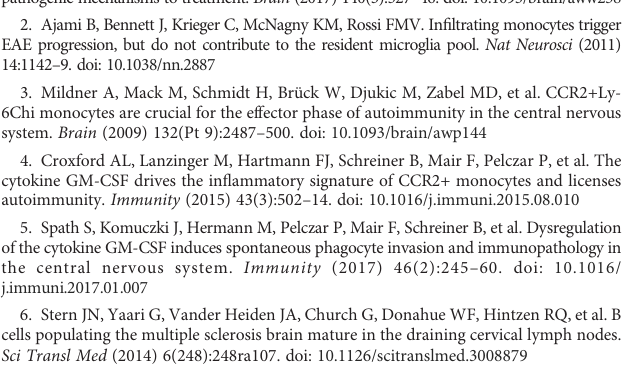
SUPPLEMENTARY FIGURE 10 DifferencesinmajorimmunecellsubsetsamongMSdiseasesubgroupsandhealthy controls. (A – E) Box plots showingthe frequency (expressed as % of CD45+ cells) of each FlowSOM generated metacluster in peripheral blood mononuclear cells of MS patients (n=27; PPMS=8, RRMS=9, TMS=10) and healthy donors. (n=10). The number below each plot represents the generated metacluster. PPMS, Primary Progressive Multiple Sclerosis; RRMS, Relapsing Remitting Multiple Sclerosis; TMS, Tumefactive Multiple Sclerosis; HD, Healthy donors. SUPPLEMENTARY FIGURE 11 Validation of myeloid cell expansion in TMS patients with fl ow cytometry. (A) Gating strategy for the myeloid immune cell phenotype (same cohort that one used in CyTOF). Representative paradigm from one patient is shown in A and generated with FlowJo program. Myeloid cells de fi ned as CD3/CD19/CD56 negative cells (total myeloid) were separated in two groups based on their forward side scattered properties: in those with higher FSC features (FSC high Myeloid) and those with lower FSC features. FSC high Myeloid cell population co-expressed the higher levels of CD11c and CD14, compared to FSC low cells, possibly indicative of their activation status. (B, C) Representative fl ow cytometry plots from each patient from the 4 groups of patients and one healthy control are presented according to gating strategies shown in A. (D) Comparative assessment of the frequency of each myeloid cell population among healthy controls (n=5), RRMS patients in remission (n=4), RRMS patients in relapse (n=4), TMS patients in remission (n=5) and TMS patients in relapse (n=5). RRMS, Relapsing Remitting Multiple Sclerosis; Rem, Remission; Rel, Relapse; TMS, Tumefactive Multiple Sclerosis; HD, Healthy donors; FSC, forward side scatter; PBMC, peripheral blood mononuclear cells. SUPPLEMENTARY FIGURE 12 Increased serum neuro fi lament light chains re fl ect disease activity in TMS patients and correlate with the expansion of the myeloid cell signature. (A) Serum neuro fi lament light chains were measured in duplicates using the high- sensitivity single-molecule array (Simoa) NF-Light Advantage Kit (Quanterix), according to the manufacturer ’ s instructions on an HDX platform (Quanterix). (B) Serum NfL in RRMS and TMS patients. (C) Correlation among NfL and myeloid cell signatures as de fi ned by analysis of CytOF (also see ) and conventional fl ow cytometry data analysis. RRMS, Relapsing-Remitting Multiple Sclerosis; TMS, Tumefactive Multiple Sclerosis; Macro, macrophages; Rem, Remission; Rel, Relapse; NfL, neuro fi lament light chains; SD, standard deviation. SUPPLEMENTARY FIGURE 13 Differences in CD8+ T cells among MS disease subgroups and healthy controls.